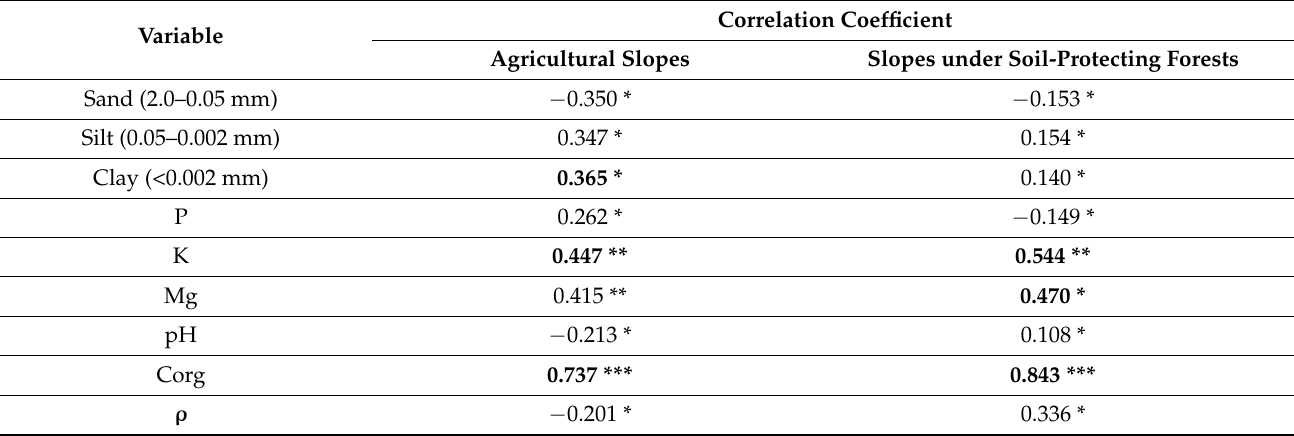
Table 3. Pearson’s correlations among the topsoil organic carbon stock (SOCP) and selected soil properties analyzed in the study area. Correlation Coefficient Variable Agricultural Slopes Slopes under Soil-Protecting Forests Sand (2.0–0.05